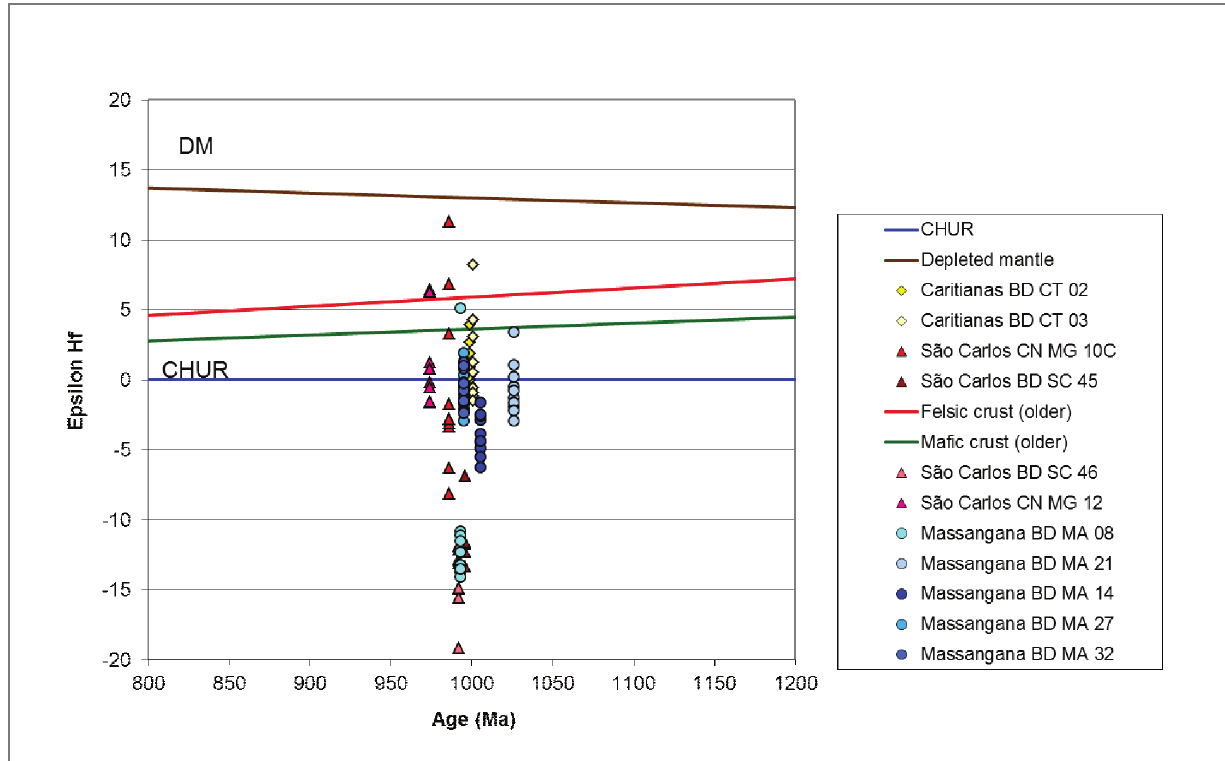
FIGURE 7 – Age vs . εHf values for the Massangana, Caritianas and São Carlos